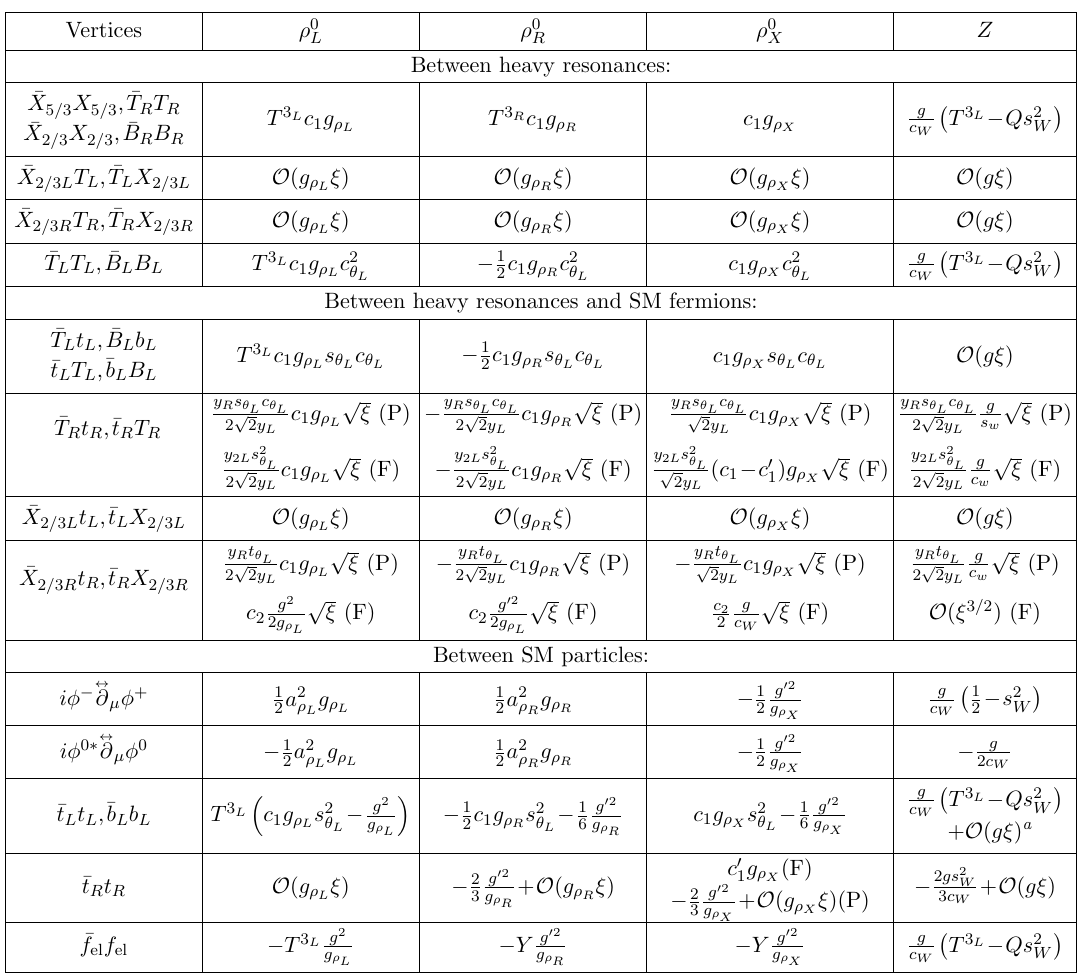
Table 3. The LO coupling strengths between the neutral spin-1 bosons, (cid:26) 0